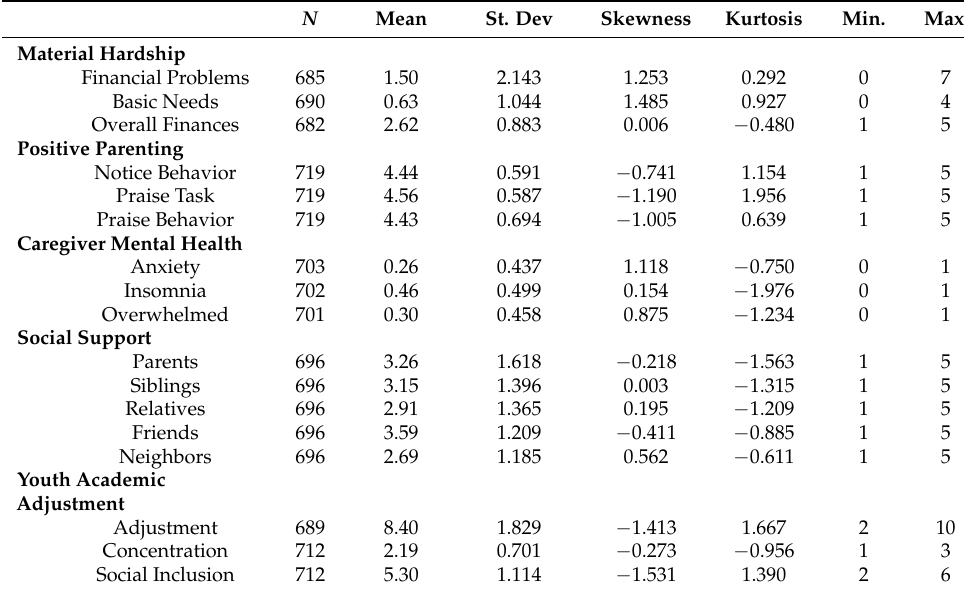
Table 1. Description of